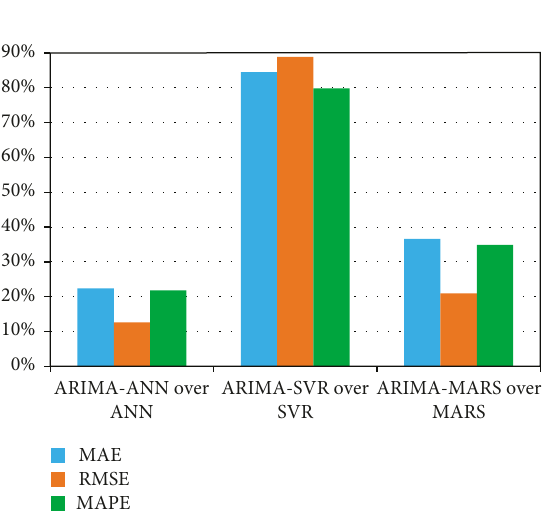
Figure 5: Average PIs by using the proposed integrated models over single ANN, SVR, and MARS models.